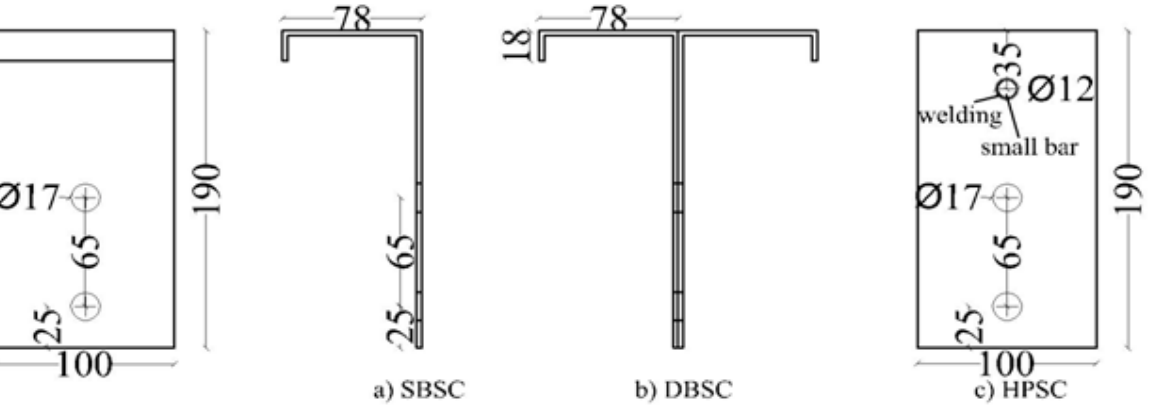
Figure 1. Types of shear connectors: ( a ) SBSC shear connector, ( b ) DBSC shear connector, ( c ) HPSC shear connector [21].